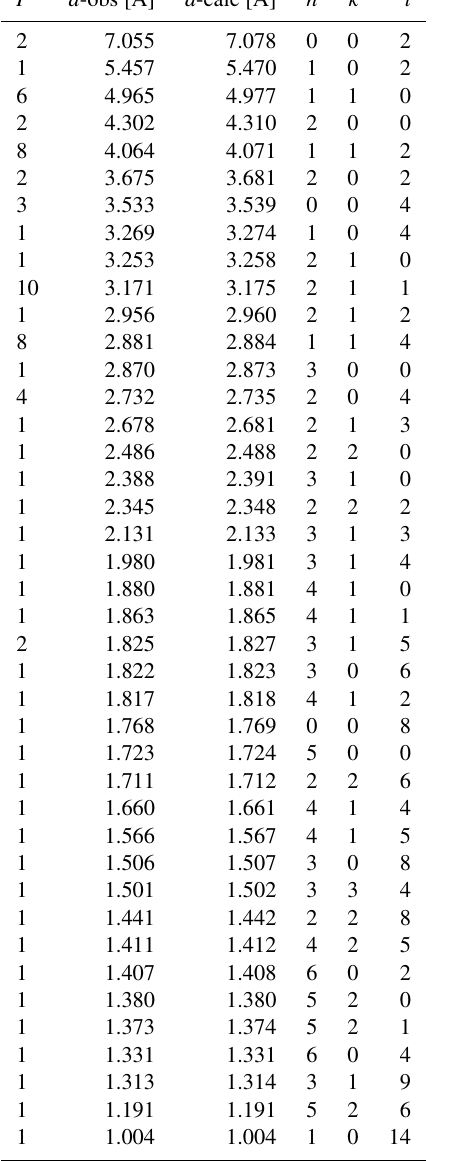
Table 5. X-ray powder diffraction data for laurentthomasite.